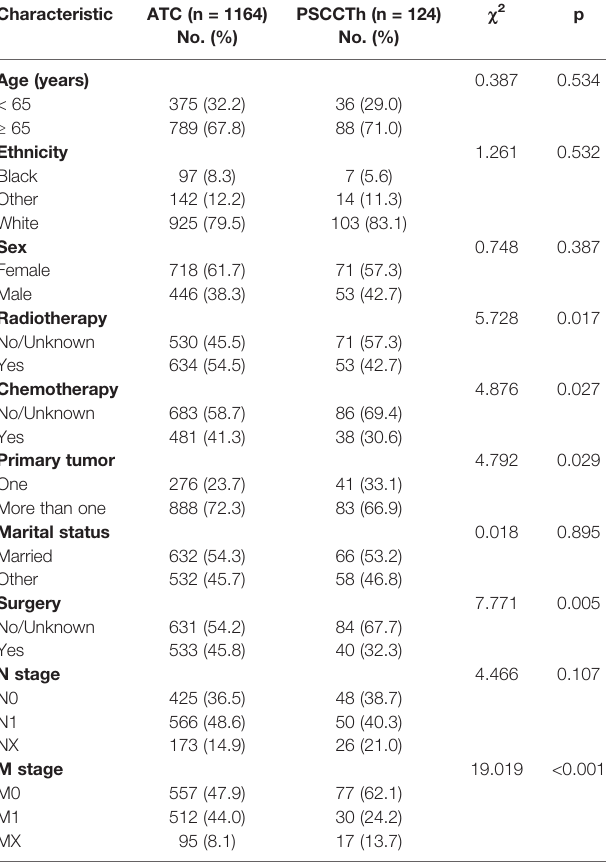
TABLE 1 | Analysis of differences in demographic and clinical characteristics between ATC and PSCCTh. Characteristic ATC (n = 1164) No.